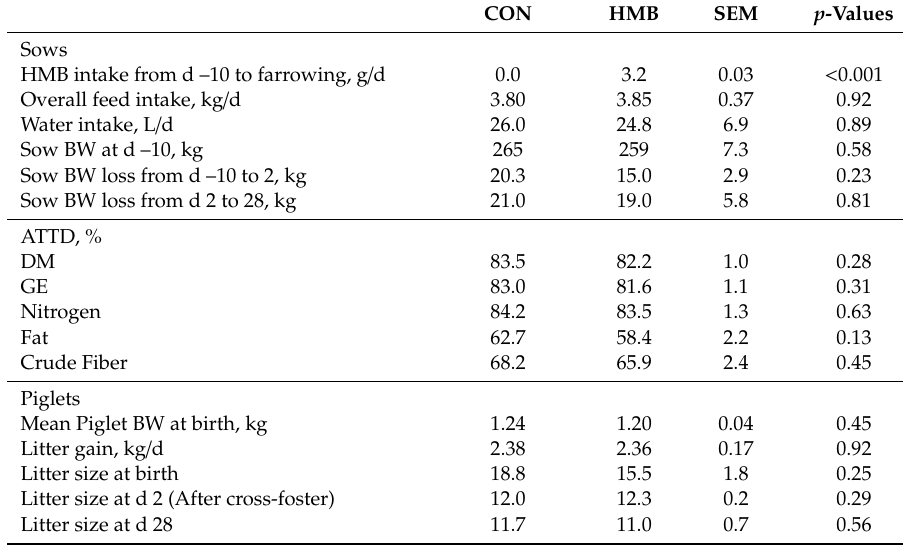
Table 1. Feed and water intake of sows and performance of sows and piglets during transition and lactation, and apparent total tract digestibility of sow diets.